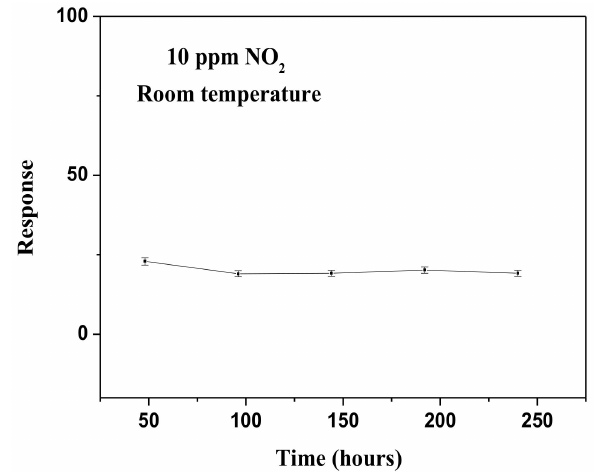
Figure 7. Stability of 3 wt.% Pt/BiVO 4 nanocomposites to 10 ppm NO 2 operating at room